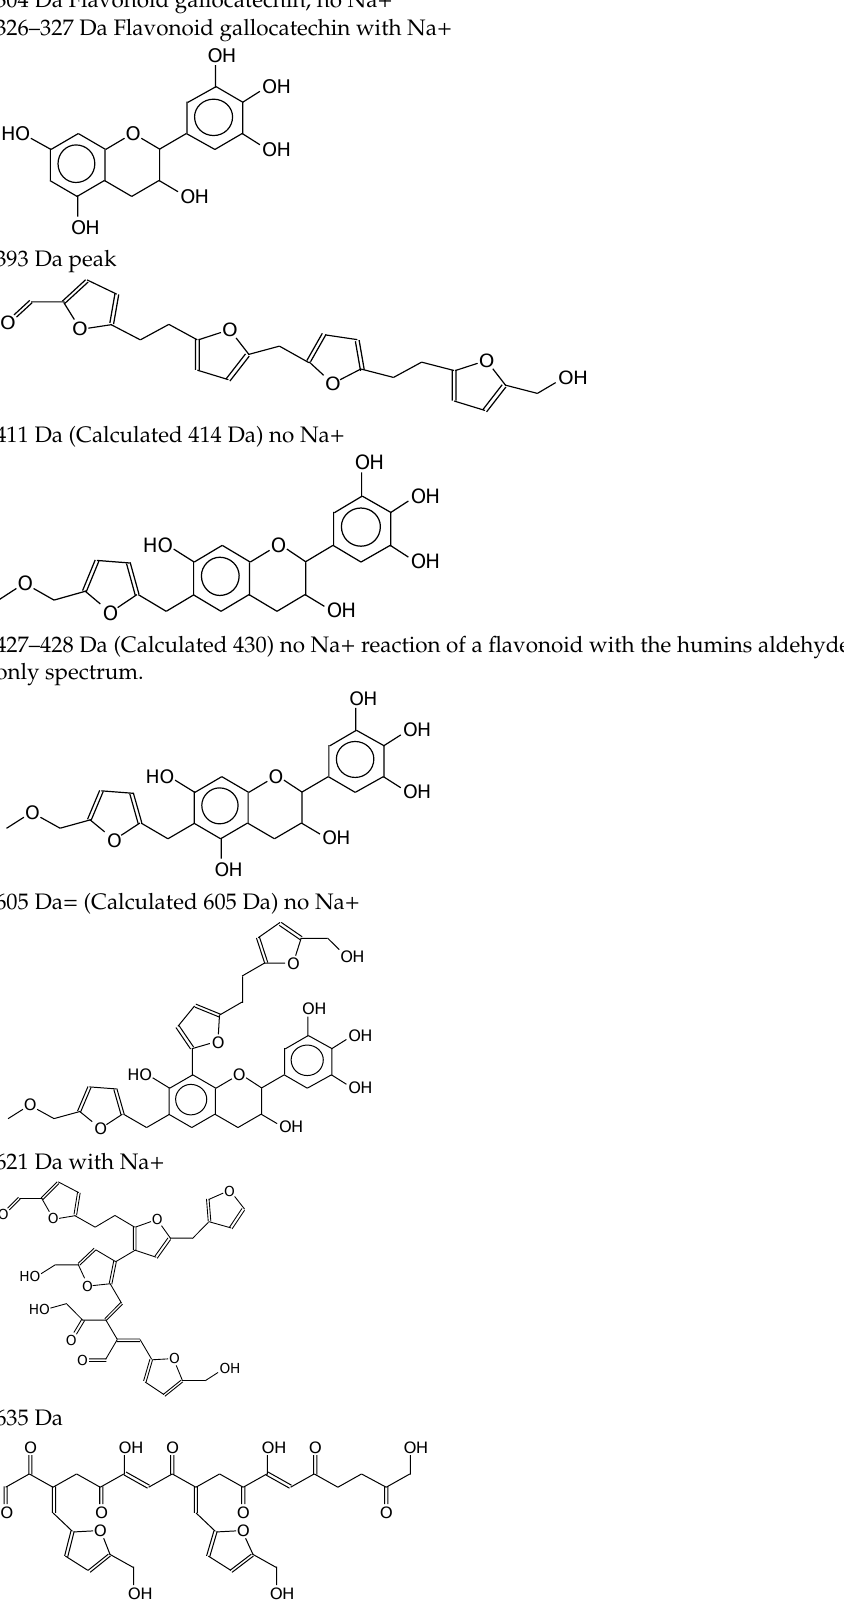
Figure 14. MALDI ToF spectrum of F-H4.5-FA6-W1.5 foams: ( a ) 300 to 600 Da range; ( b ) 600 to 900 Da range; ( c ) 900 to 1200 Da range; ( d ) 1200 to1500 Da range; ( e ) 1500 to 1800 Da range; ( f ) 1800 to 2100 Da range. Table 4. MALDI ToF analysis assignments of relevant peaks of foam F-H4.5-FA6-W1.5. 304 Da Flavonoid gallocatechin, no Na+ 326 – 327 Da Flavonoid gallocatechin with Na+